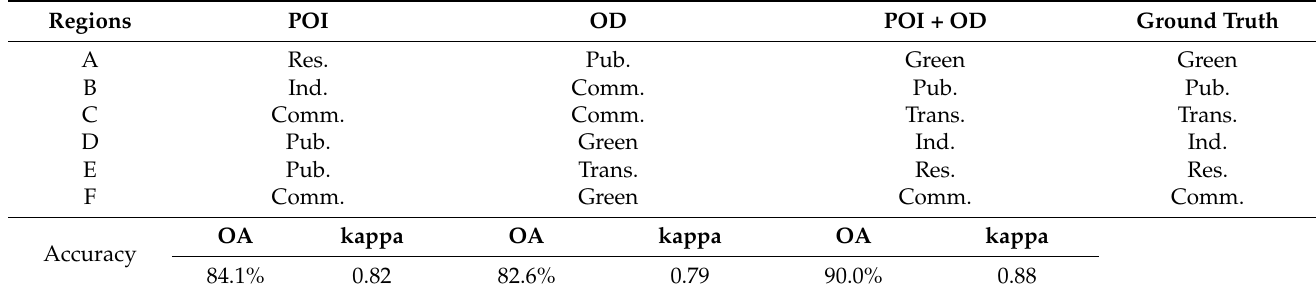
Figure 7. Identification results obtained using single data sources (i.e., without data fusion): ( a ) POI results and ( b ) taxi results; and ( c ) results obtained using fused data. (Different circles denotes 6 typical regions for qualitative validation. The results were shown in Table 6). Table 6. Comparison of the results and accuracy in different spatial units.